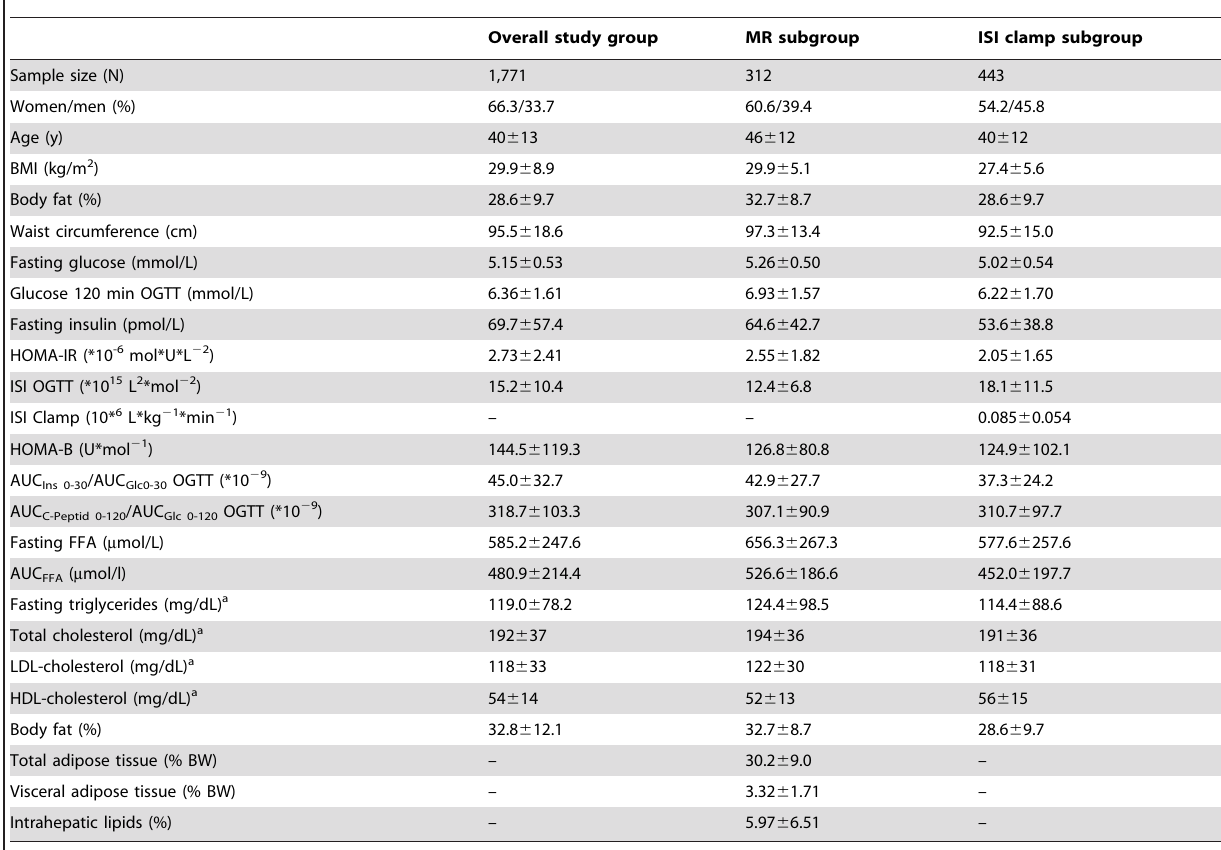
Table 1. Clinical characteristics of the study